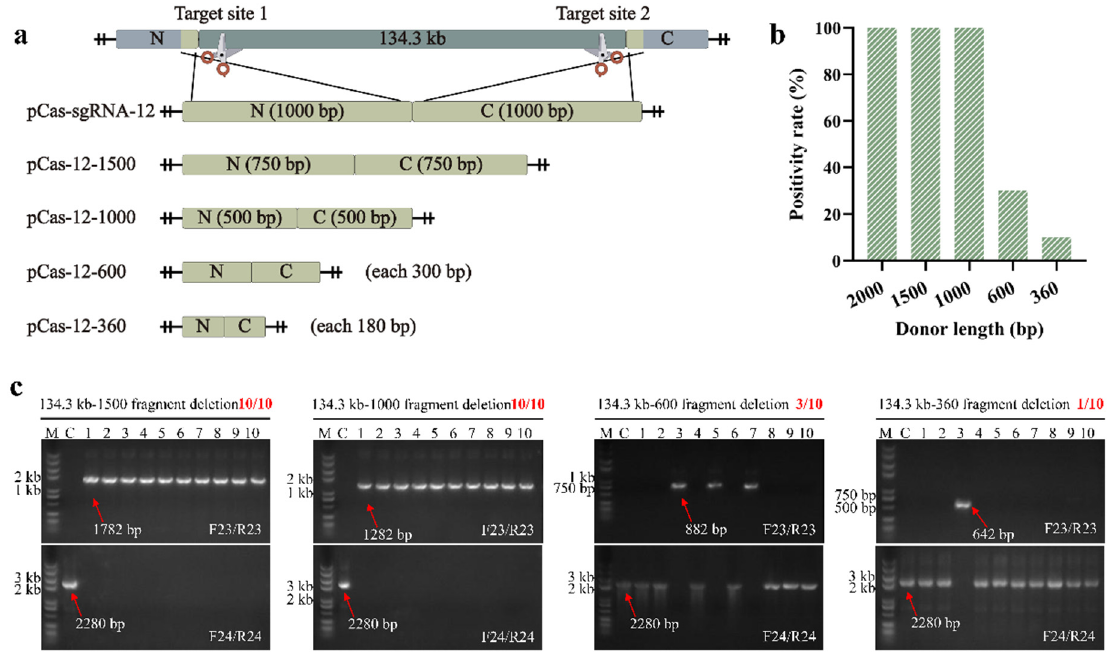
Figure 4. Effect of donor DNA size on the positivity rate of 134.3 kb fragment deletion ( a ) The lengths of the donor DNA templates are 2000, 1500, 1000, 600 bp and 360 bp, respectively. ( b ) The positivity rate of 134.3 kb fragment deletion under different lengths of donor DNA. ( c ) Using primers F23/R23 and F24/R24, the 134.3 kb fragment deletions mediated by different lengths of donor DNA (15,001,000,600 and 360 bp) were